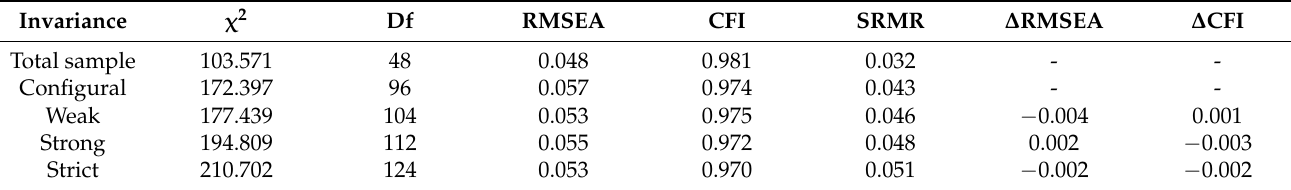
Table 2. Measurement invariance between WSs and